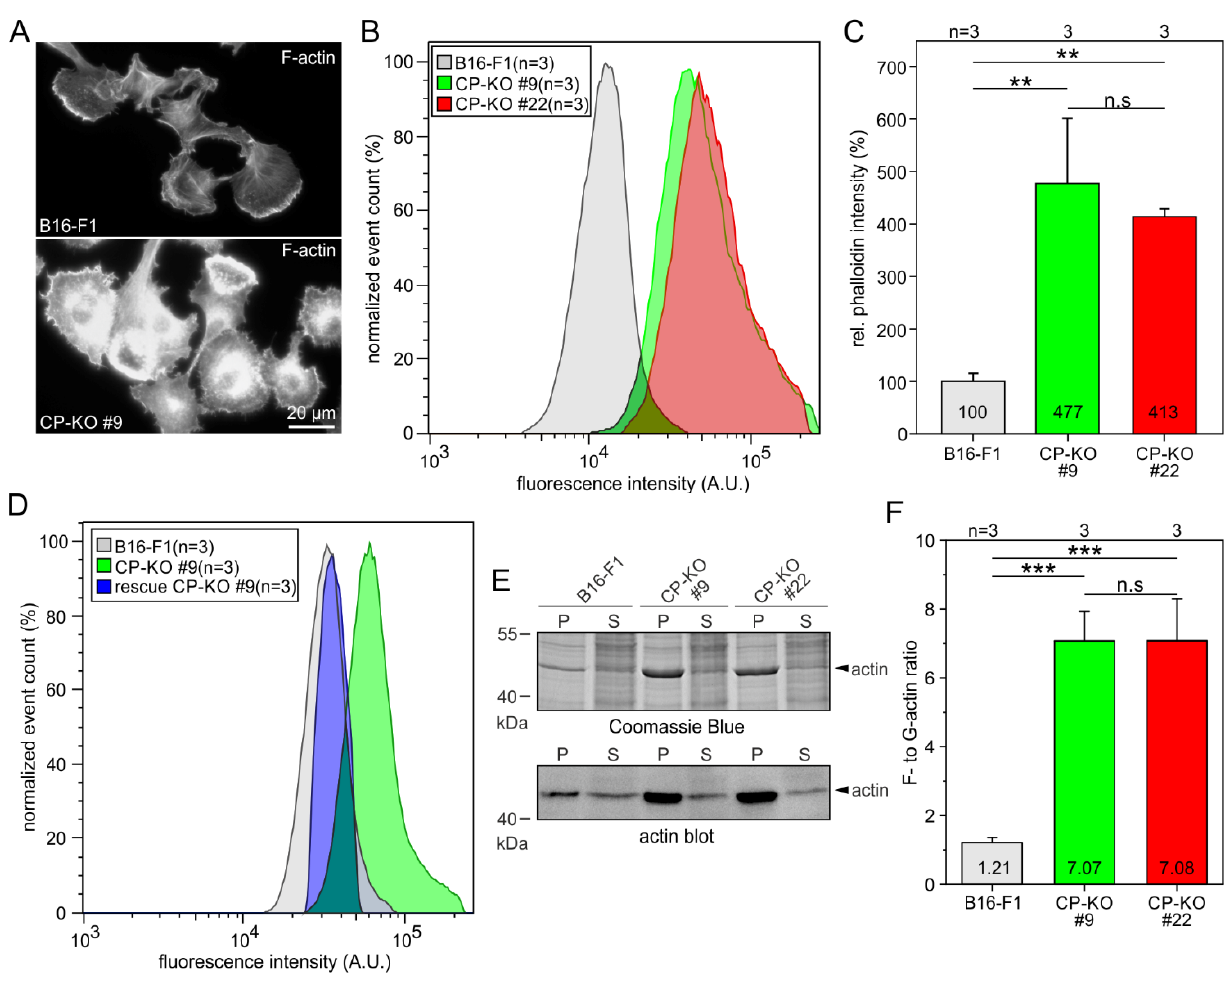
Figure 2. Loss of CP results in markedly increased F-actin levels. ( A ) Representative examples of B16-F1 cells and derived CP-KO mutant stained with phalloidin for the F-actin cytoskeleton and imaged at identical settings. Note the much brighter phalloidin signal in CP-KO cells. ( B ) Flow cytometry of phalloidin-stained B16-F1 cells and two independent CP-KO mutant cell lines. ( C ) Quantification of F-actin content from flow cytometry experiments shown in ( B ). ( D ) Flow cytometry of phalloidin-stained B16-F1 wild-type, CP-KO and reconstituted CP-KO cells expressing EGFP-CP-β. ( E ) Immunoblot depicting actin levels in pellet (P) and supernatant (S) fractions of B16-F1 and derived CP-KO mutants. The corresponding Coomassie Blue-stained gel is shown above. Note the prominent band of approximately 42 kDa in the pellet fractions of the mutant cells, which most likely represents actin. ( F ) Quantification of actin in pellet (P) and supernatant (S) fractions from immunoblots shown in ( E ). ( C , F ) Bars represent arithmetic means ± SD. Non-parametric, Kruskal–Wallis test and Dunn’s Multiple Comparison test ( C ) and one-way ANOVA and Tukey Multiple Comparison test ( F ) were used to reveal statistically significant differences between datasets. ** p ≤ 0.01, *** p ≤ 0.001; n.s.: not significant. n: number of independent experiments using approximately 5 × 10 4 cells for each cell line ( B , D ) or the number of independent experiments ( C , F ).